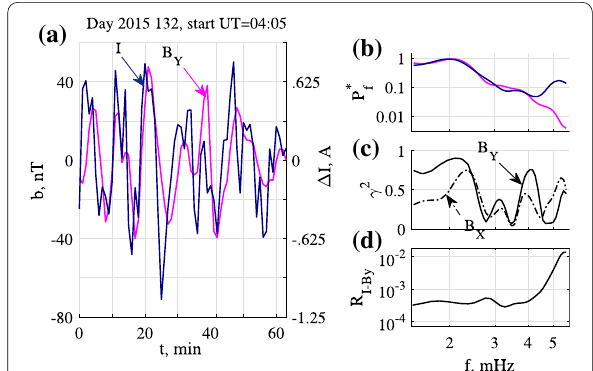
Fig. 5 Event 2 Pulsations recorded in the geomagnetic field and GIC on day 2015 132. a waveforms of B Y pulsations at KEV (magenta) and GIC at VKH (dark blue); b normalized PSD spectra; c B − I spectral coherence for B Y (solid) and B X (dashed); d I to B Y PSD ratio